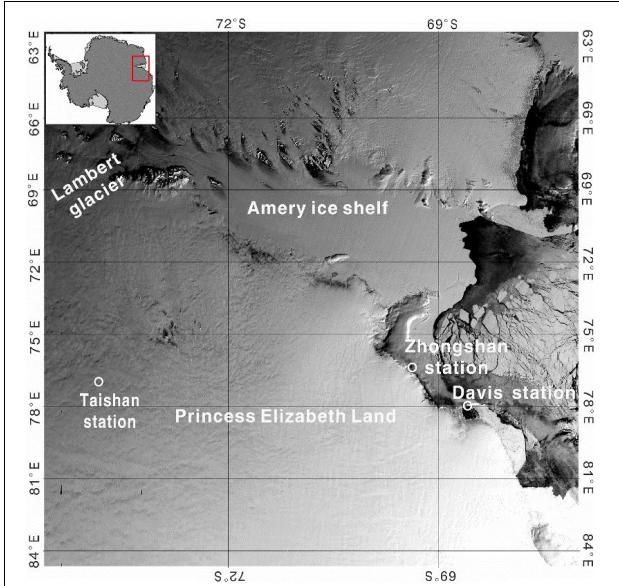
FIGURE 1 | The Moderate Resolution Imaging Spectroradiometer (MODIS) image of the new Chinese Taishan Station (73 ◦ 51 (cid:48) 50 (cid:48)(cid:48) S, 76 ◦ 58 (cid:48) 28 (cid:48)(cid:48) E), including the drainage system of the Lambert glacier–Amery ice shelf, Princess Elizabeth Land, the Chinese Zhongshan Station, and the Australian Davis Station.